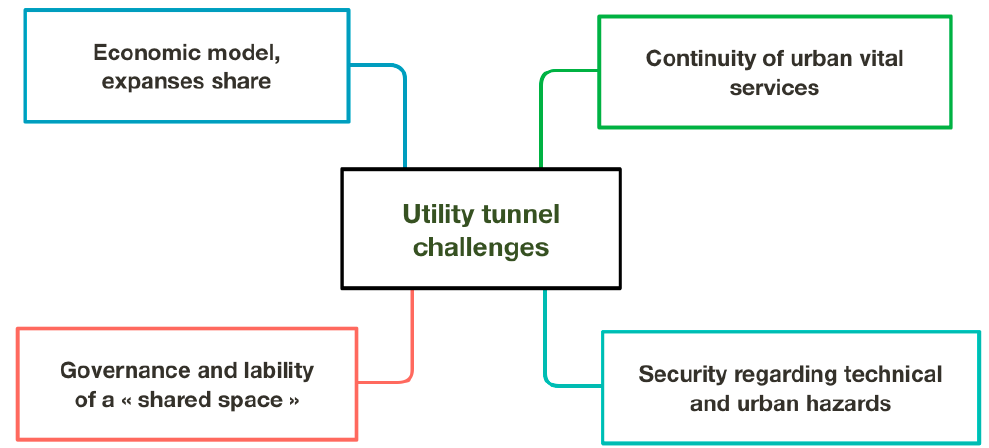
Figure 2. Challenges facing utility tunnels.